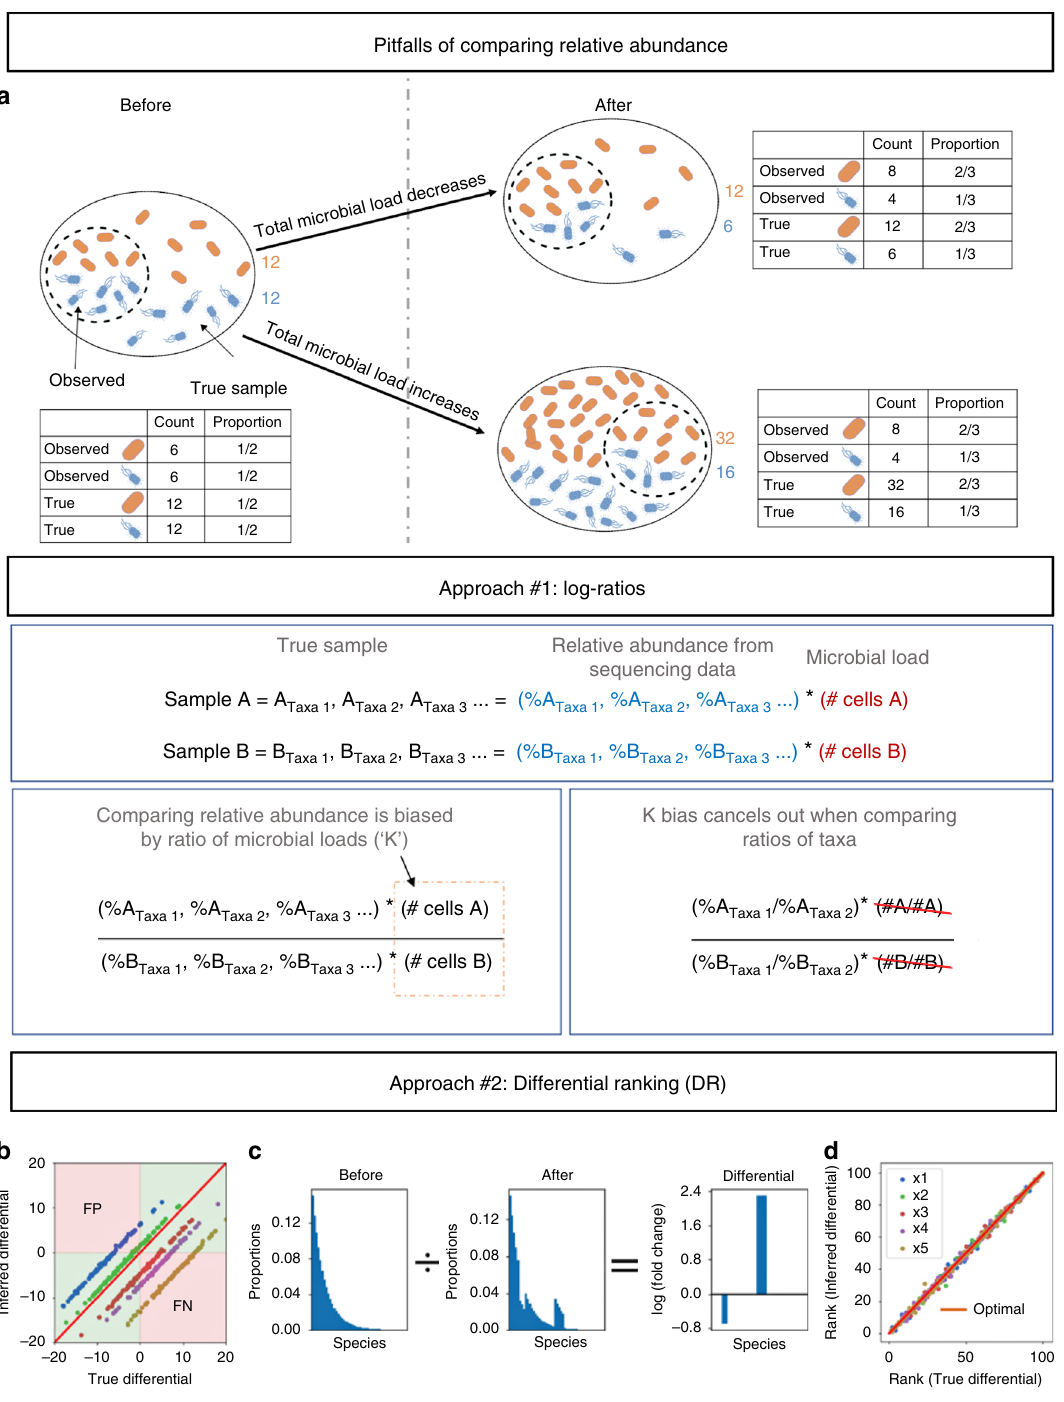
Fig. 1 Illustration demonstrating statistical limitations inherent in compositional datasets. a Two different biological scenarios can yield the exact same proportions of taxa in samples from a population pre- and post-treatment. b Simulated datasets plotting the true differential obtained using absolute abundance data on the x -axis, versus the inferred differential obtained using relative abundance data on the y -axis. Each dot represents a taxon in the dataset, and the colors represent datasets with various ratios of total microbial load (K) between before and after samples. The red line represents the optimal scenario where the samples have equal microbial load. This illustrates the prevalence of either false positives (FP) or false negatives (FN) when performing differential abundance analysis on samples with unequal total microbial load. The presence of either FPs or FNs is dictated by a nonlinear function of the true differential (see online methods). c An illustration of differential proportions of bacterial species before and after treatment. d Same data as b but plotting the rank of the differentials, demonstrating that ranks are equivalent regardless of differences in microbial